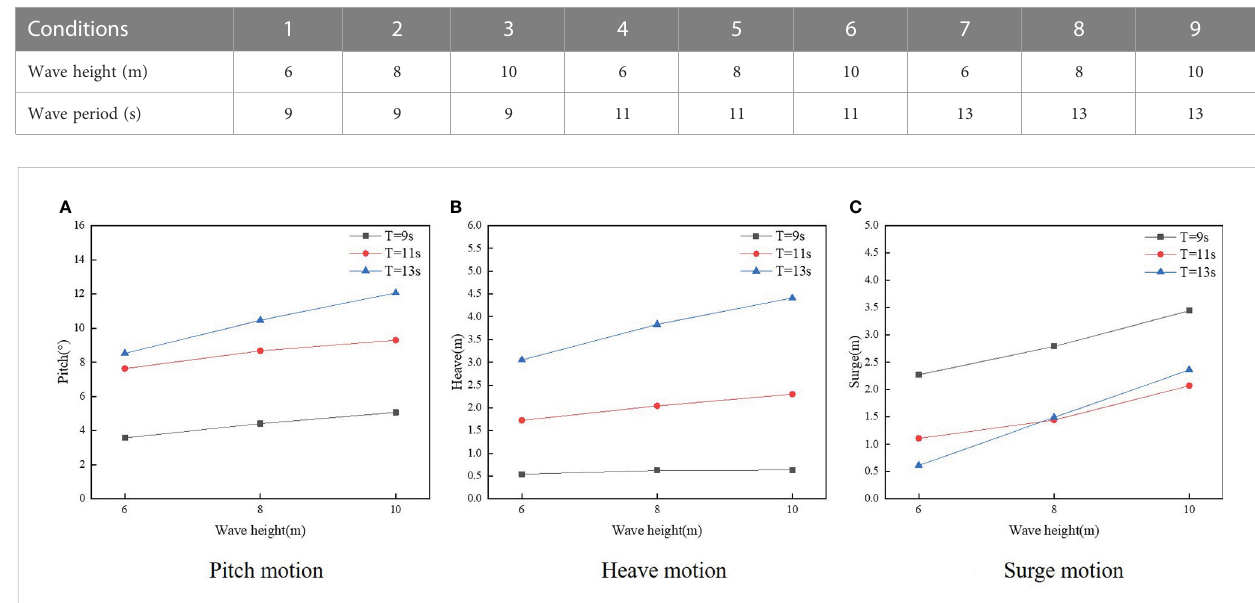
FIGURE 10 Motion response of fi sh farm platform under different wave